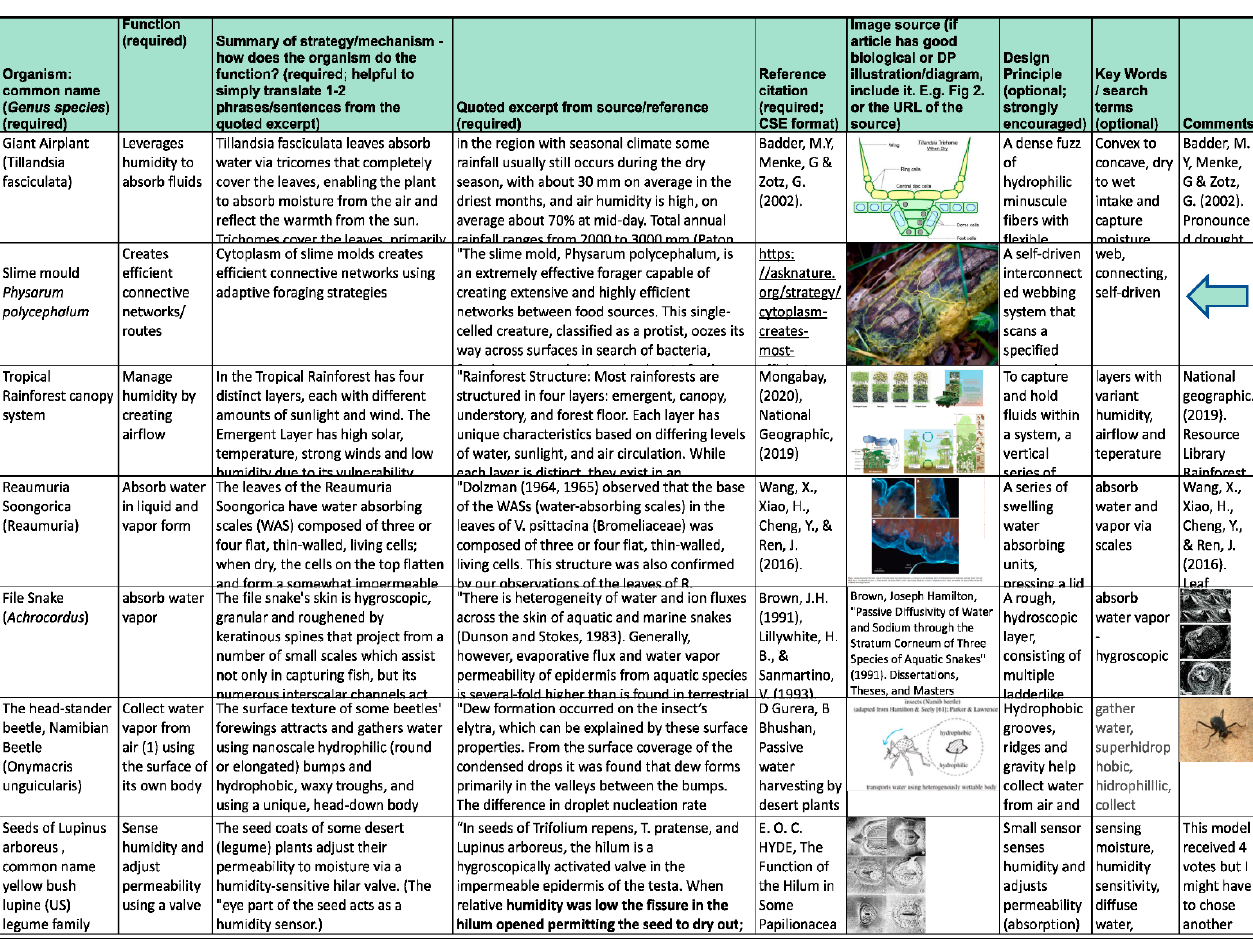
Figure 3. Example of BioBrainstorming and research. Badder, Menke & Zotz; AskNature; National Geographic; Wang, Xiao, Cheng & Reng; Gurera & Bhushan; Hyde.